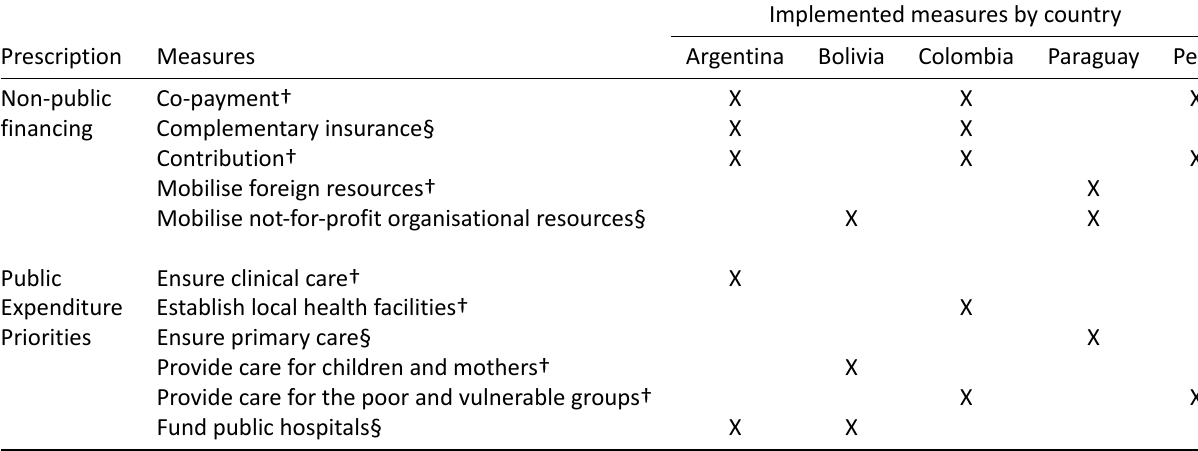
Table 4. Financing